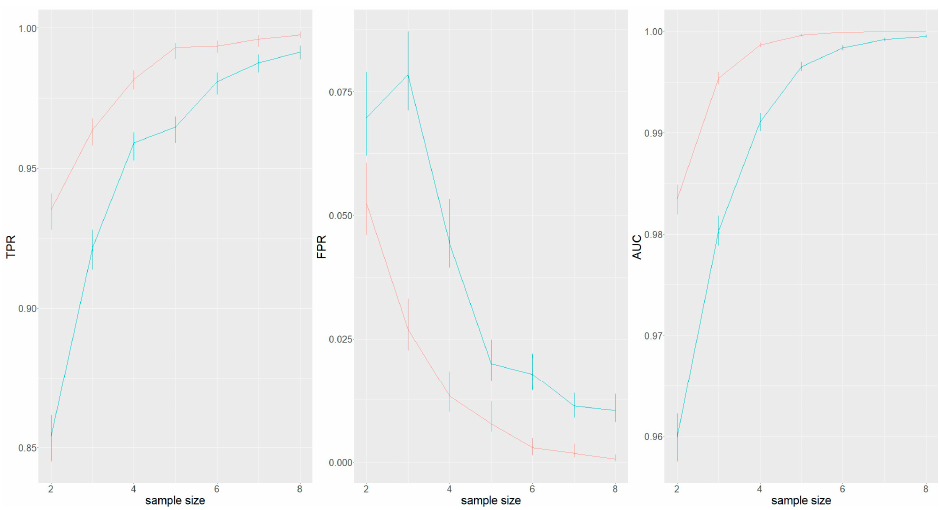
Figure 4. True positive rate (TPR) ( left ), false positive rate (FPR) ( middle ), and area under the curve (AUC) ( right ) are given as a function of the sample size n for average OD (green) and Bayes factor (red) as